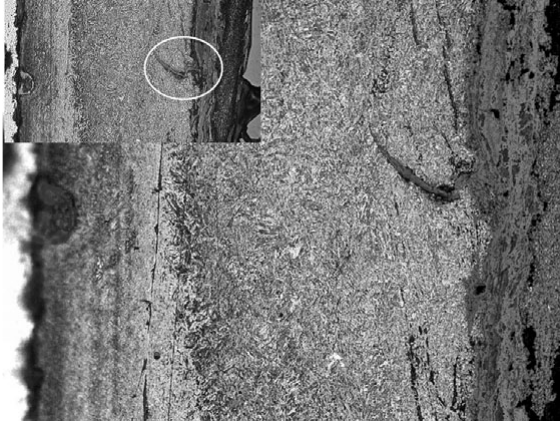
Fig. 2. Microstructure of the studied rail-segment after annealing on 250°C / 4hrs – etched in NITAL, magn. 250x and 50x,